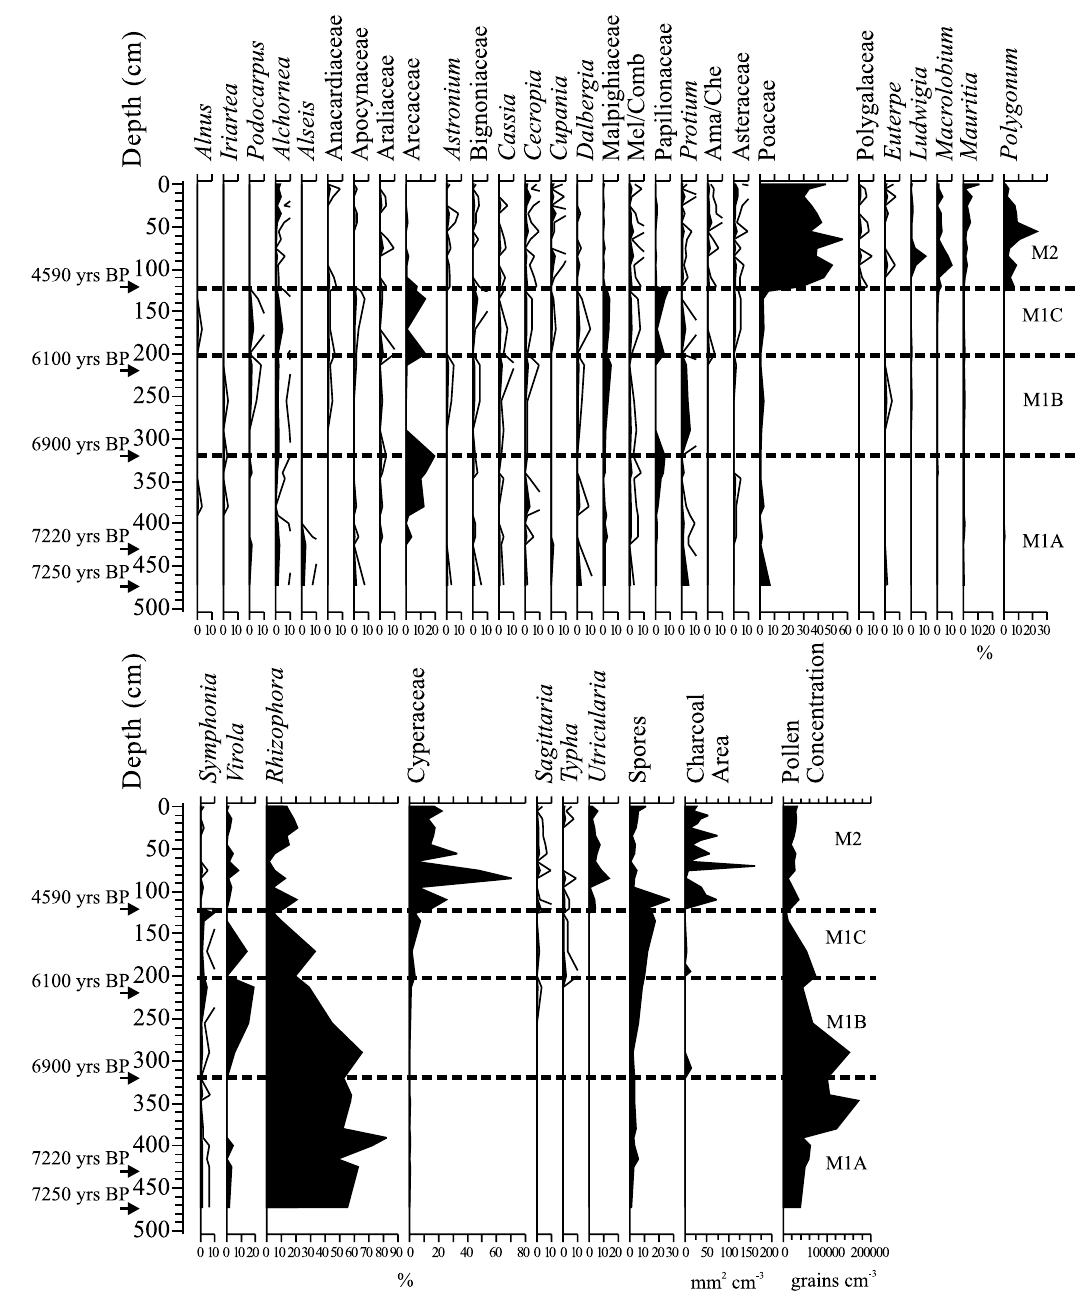
Fig. 3 – Pollen percentage diagram of Lake Márcio, Amapá (Brazil), showing the most representative taxa, including Andean taxa, area of charcoal particles (mm 2 cm –3 of sediment), pollen concentration (grains cm –3 of sediment), and radiocarbon dates (cal years BP). The hollow curves are exaggerated 5